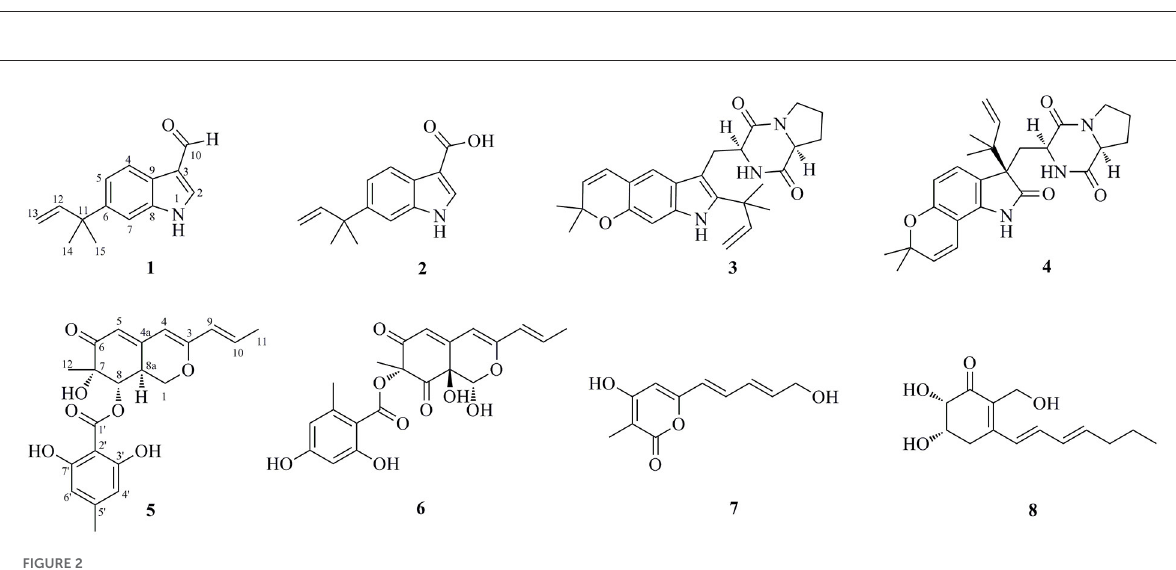
FIGURE1 Morphology of Aspergillus flavipes DS720 cultured on PDA medium [ (A) , front view; (B) reverse view]; (C) Neighbor-joining tree based on ITS and β -tubulin sequences.